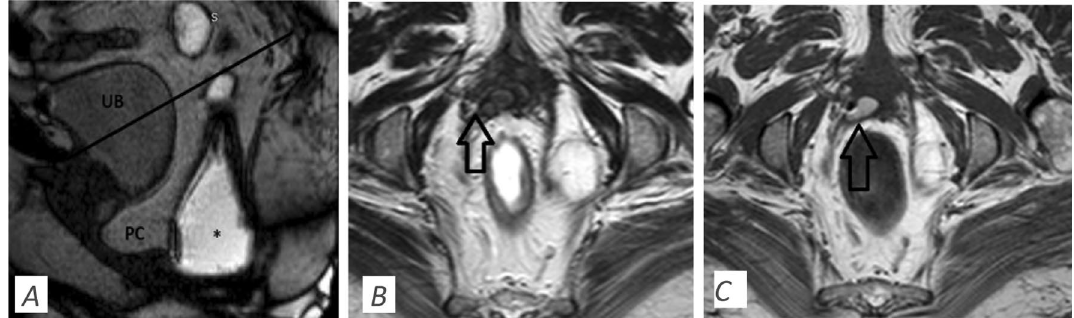
Fig. 8 A 40-year-old patient having new symptoms after tension free vaginal tape for SUI showing: A Sagittal BFFE MRD during evacuation showing a cystocele measuring 2.5 cm, uterine descent measuring (3.2 cm) below PCL (green line). Horizontal orientation of the urethra (*) with kink at the bladder base that was further studied and correlated with the static images. B , C Axial static T1W MR images pre- B and post- C IV contrast administration showing an area of abnormal contrast enhancement (red circle) denoting